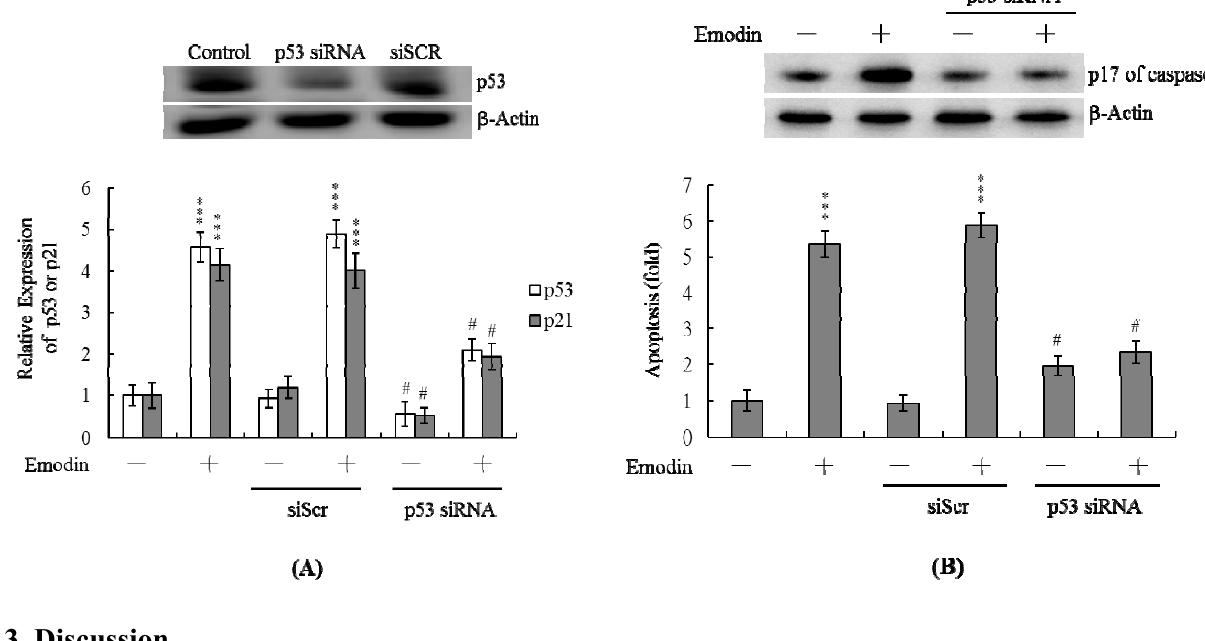
Figure 6. Knockdown of p53 protects IMR-32 cells against emodin-induced apoptosis. IMR-32 cells were transfected with siRNA targeting p53 and scrambled siRNA duplex (siScr), incubated for 24 h, and treated with 20 μ M emodin for a further 24 h. ( A ) The protein expression levels of p53 were detected by immunoblotting. The mRNA levels of p53 and p21 were analyzed using real-time PCR; ( B ) Active form caspase-3 (cleavage products of caspase-3; p17) were detected by immunoblotting. Apoptosis was detected with the Cell Death Detection ELISA kit. *** p < 0.001 versus the untreated control group. # p < 0.001 versus the “emodin-treated”